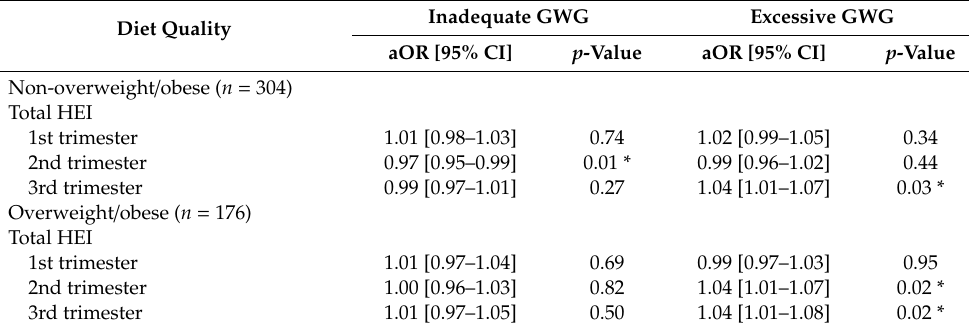
Table 5. Adjusted OR for associations between total HEI score in each trimester and GWG stratified by pre-pregnancy BMI. Inadequate GWG Excessive GWG Diet Quality aOR [95% CI] p -Value aOR [95% CI] p -Value Non-overweight / obese ( n = 304) Total HEI 1st trimester 1.01 [0.98–1.03]